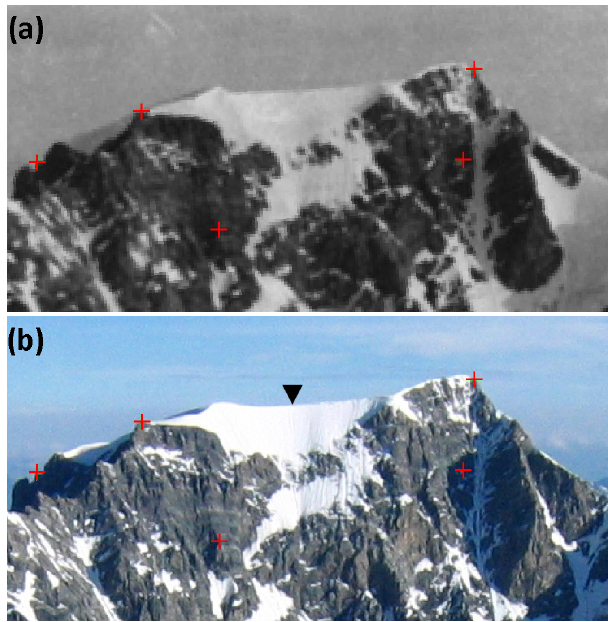
Figure 2. Comparison of terrestrial photographs of Mt. Ortles taken from the summit of Gran Zebrù (3851m) (a) during the years 1900–1930 (http://www.montagnedifoto.com/, last access 16 March 2016) and (b) on the 4 July 2010 (photo: Roberto Seppi). The triangle in panel (b) shows the position of the 2011 drilling site. The four symbols ( + ) indicate the reference points used for co-registering the two photos (ESRI ArcMap ™ ) before estimating the thickness variation at the drilling site during this